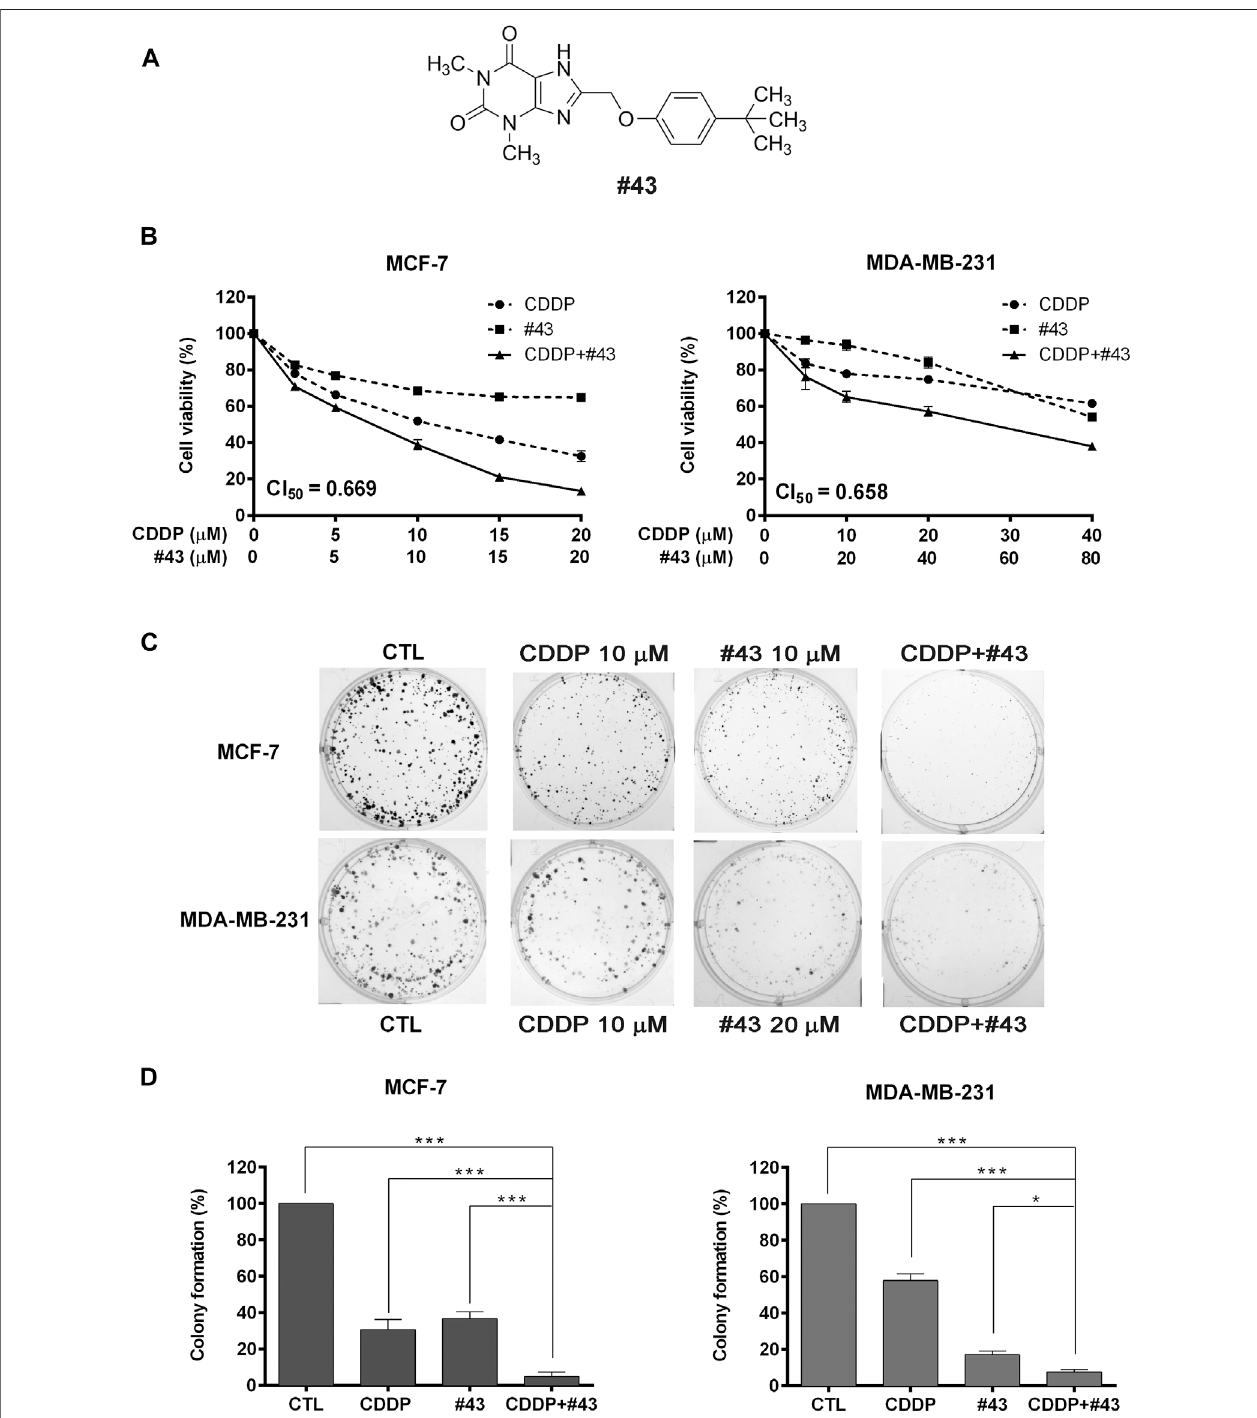
FIGURE 1 | Effects of cisplatin and #43 on growth inhibition and clonogenicity in MCF-7 and MDA-MB-231 cells. (A) Structure of #43. (B) Dose-response curves and CI 50 values of MCF-7 (left panel) and MDA-MB-231 cells (right panel) treated with cisplatin (CDDP) and #43 either alone or in combination for 72 h. The MTT assay was used to measure the cell viability. (C) Representative images of colony formation assay. MCF-7 and MDA-MB-231 cells were treated with indicated concentrations of cisplatin for 1 h and/or #43 for 10 – 12 days. (D) Quantitative results of colony formation assay. Data are presented as mean ± SEM of at least three independent experiments. *, p < 0.05; ***, p < 0.001 by one-way ANOVA followed by Bonferroni t -test.